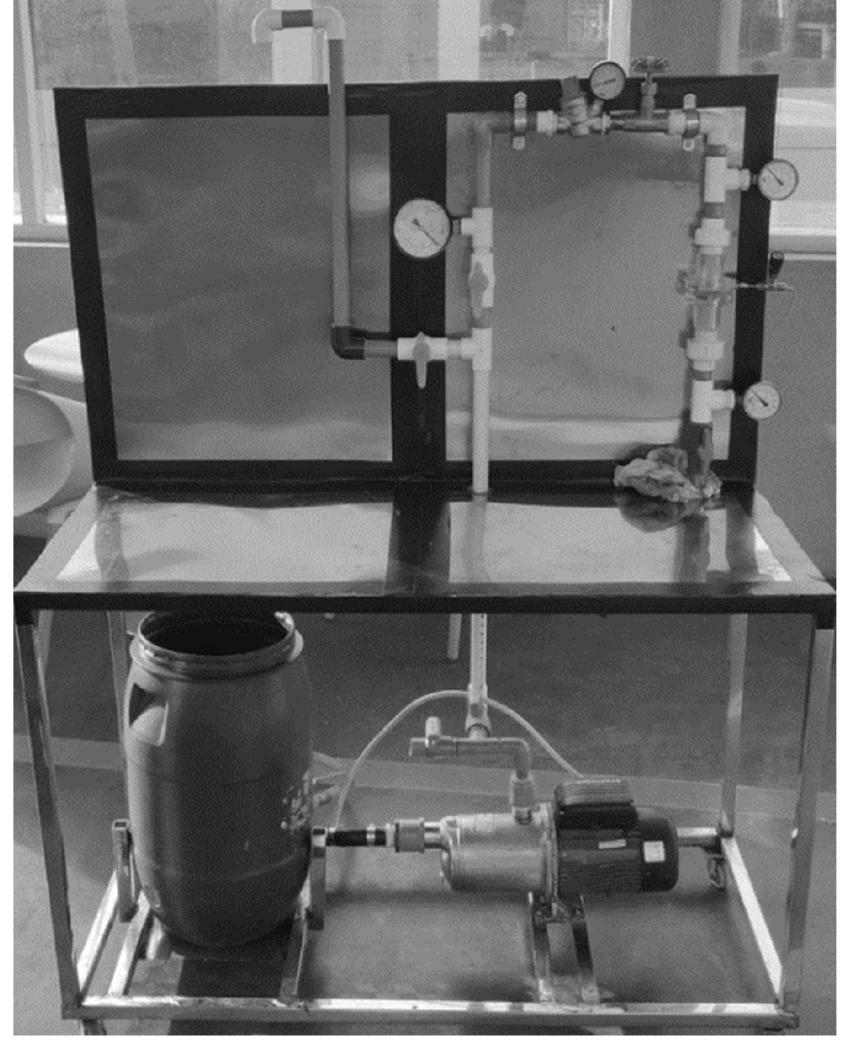
Figure 4. Flow loop test bench.